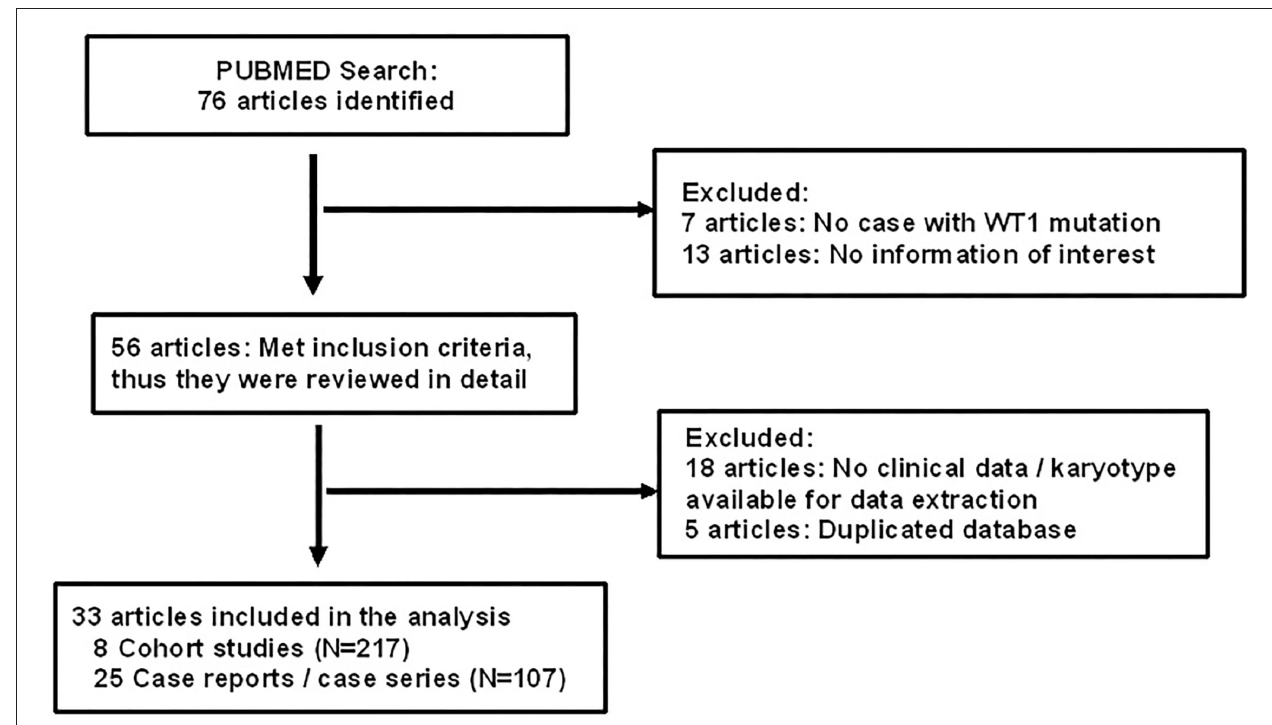
FIGURE 1 | Flow chart showing identification and selection of cases having WT1 glomerulopathy with data on age, karyotype, and phenotype.